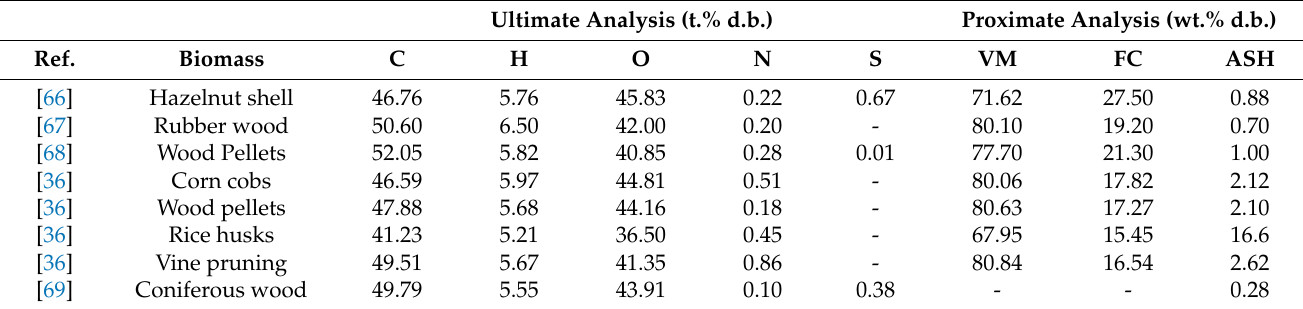
Table 2. Ultimate and proximate analyses of biomass used for the validation of models. Ultimate Analysis (t.% d.b.) Proximate Analysis (wt.% d.b.)